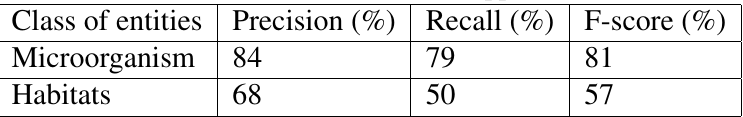
Table 3: Performance of our approach